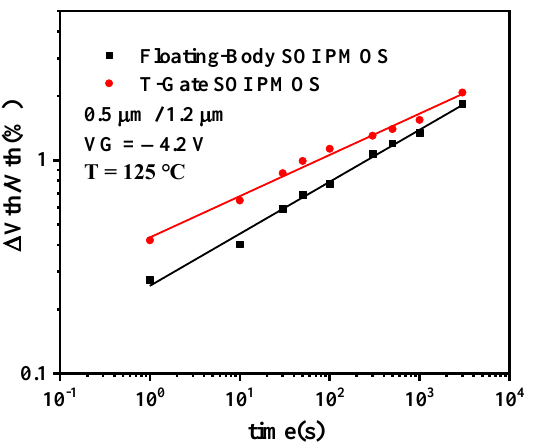
Figure 12. Comparison of NBTI degradation between floating-body and T-Gate SOI PMOSFET.